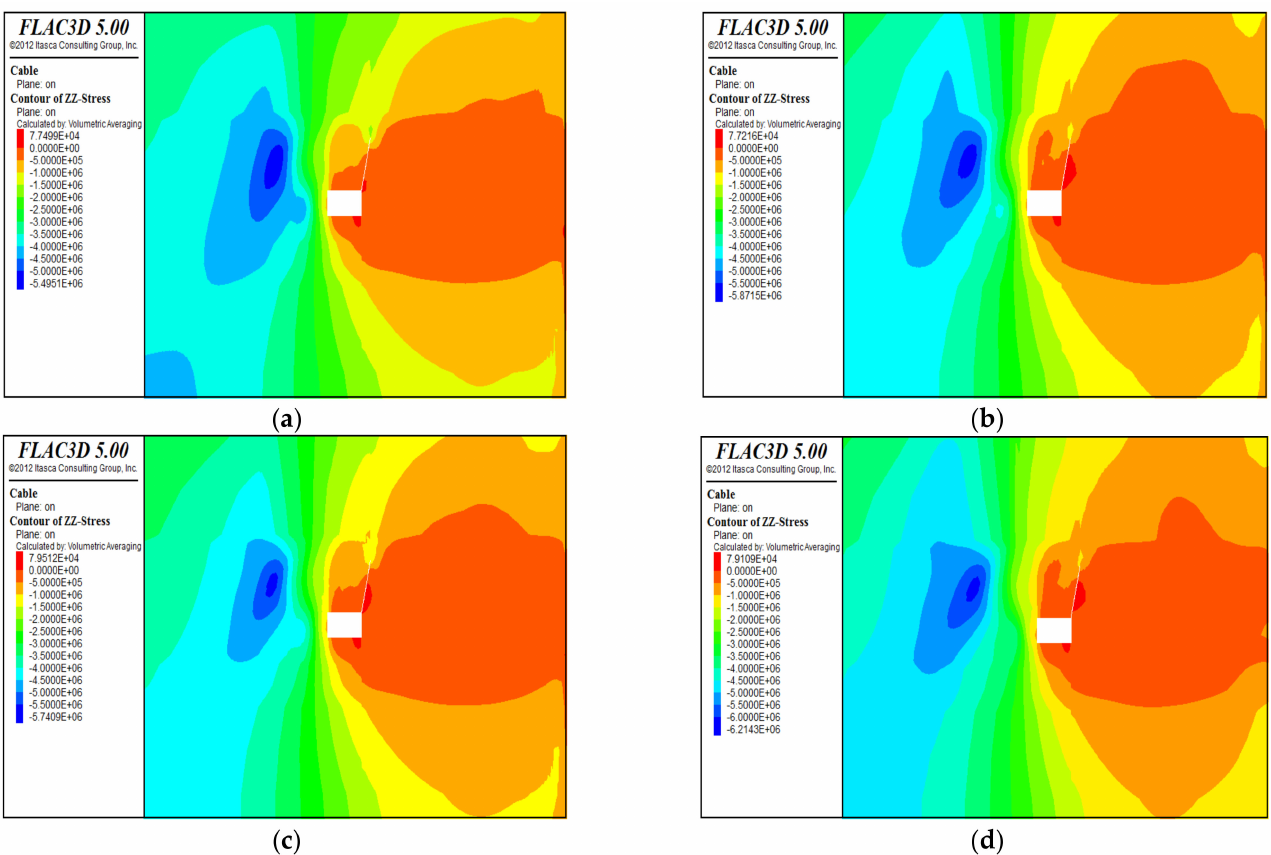
Figure 7. ( a ) Vertical stress diagram at 15 m behind the working face; ( b ) vertical stress diagram at 25 m behind the working face; ( c ) vertical stress diagram at 40 m behind the working face; ( d ) vertical stress diagram at 50 m behind the working